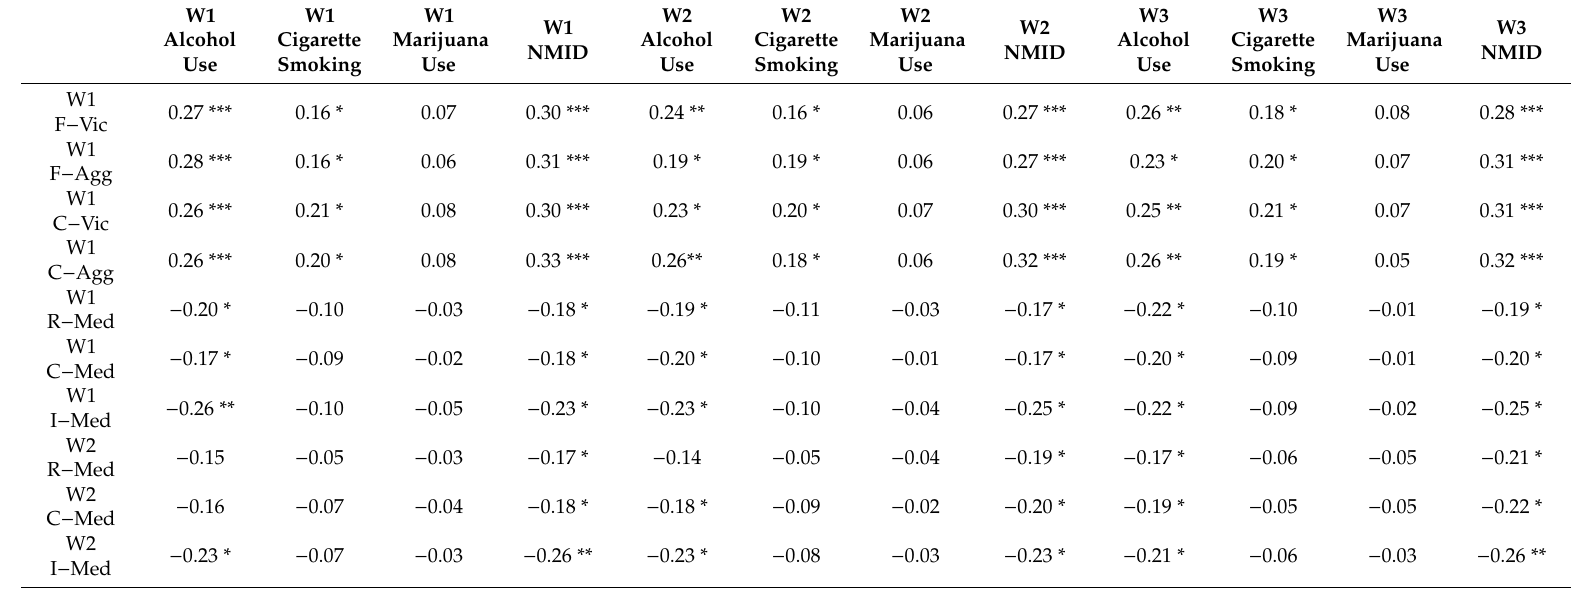
Table 2. Correlations among face-to-face victimization, face-to-face aggression, cyber victimization, cyber aggression, parental mediation, and substance